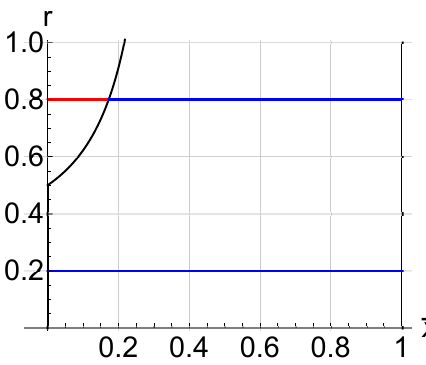
Figure 4. f 1,2 ( r , ¯ x ) —the optimal potential distribution for coupling between the first two modes.